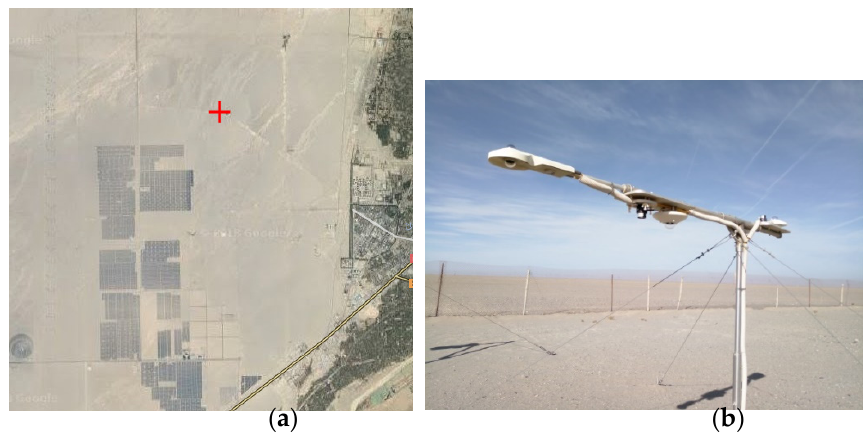
Figure 2. Photographs of the observation site at Dunhuang. ( a ) Google Map (the red cross indicates the location); ( b ) The instrument at the observation station.